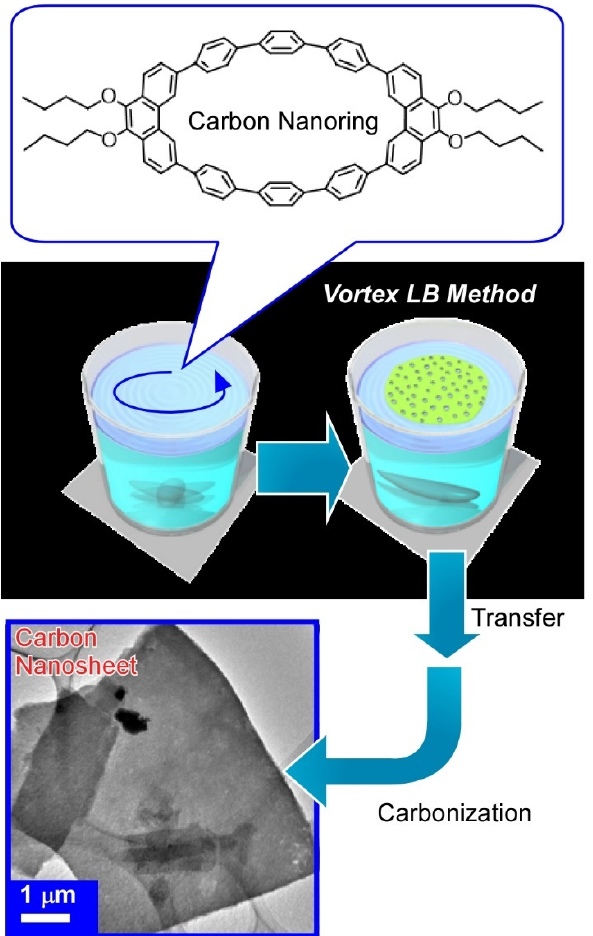
Figure 16. Nanoarchitectonics for preparation of carbon nanosheet from carbon ring molecule (9,9’,10,10’-tetrabutoxy-cyclo-[6]-paraphenylene-[2]-3,6-phenanthrenylene) through vortex Langmuir-Blodgett (vortex LB) method and calcination at 850 °C under N 2 gas flow.